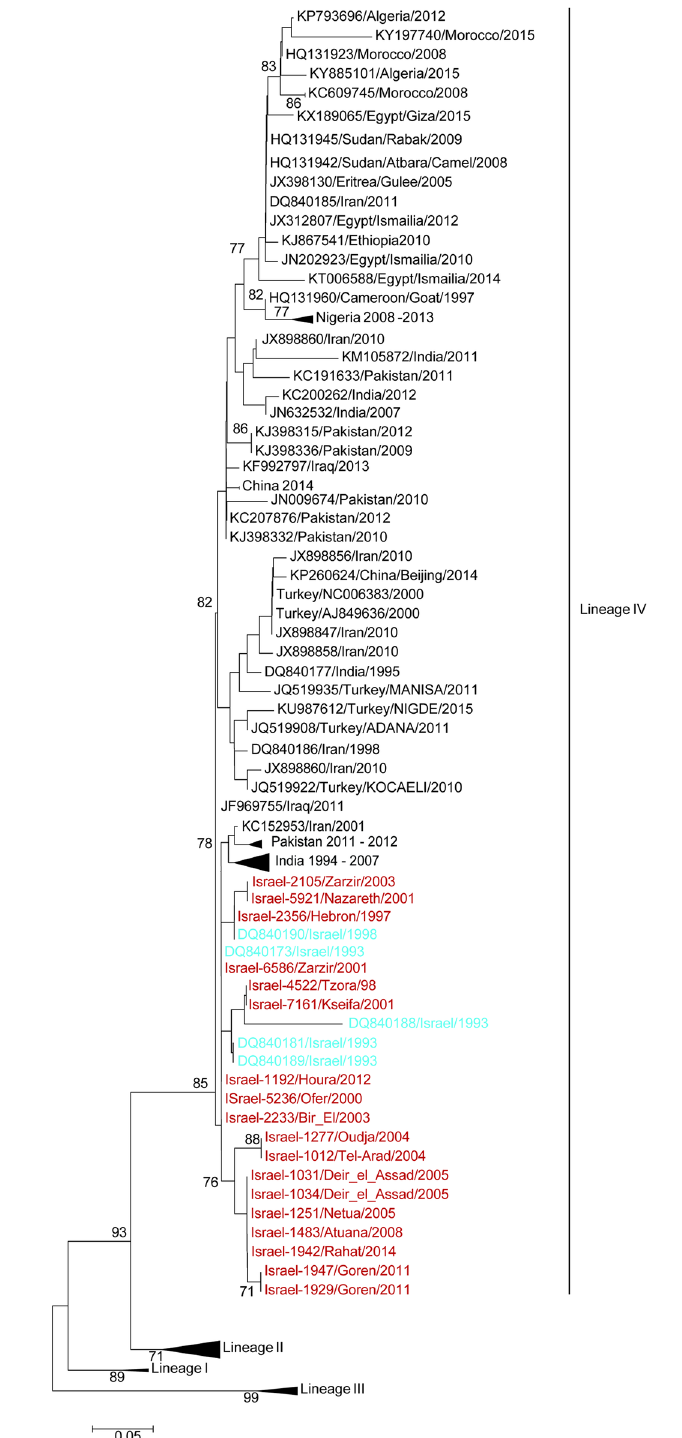
Fig 4. Neighborhood-Joining tree of all unique partial N PPRV Isolates. Accession number, country of origin, and samplingyear of each isolate is shown. Significantbootstrapvalues are includedat the nodes. All sequencesgeneratedin this study are highlightedin red and isolates previously sequencedfrom Israel are highlightedin blue.